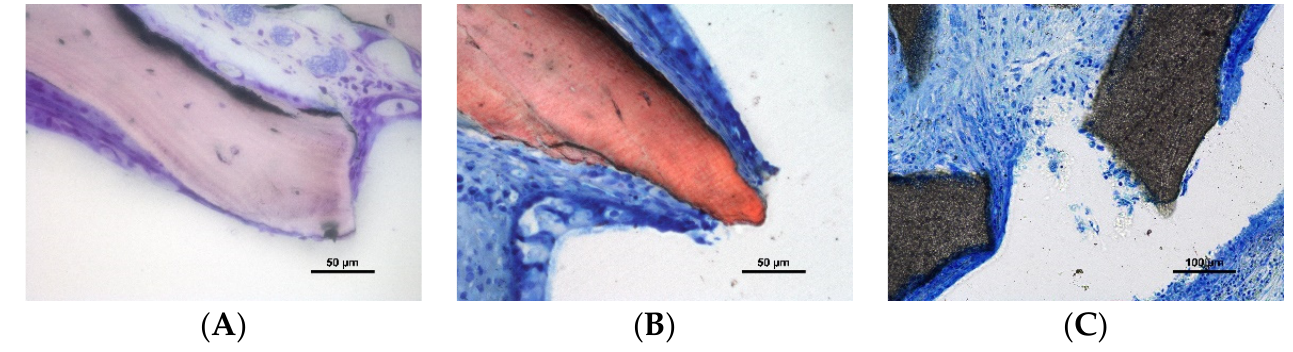
Figure 4. Photomicrographs of ground sections. Perforations of the sinus mucosa. Note the tapered shape of the epithelium in a tentative attempt to protect the subjacent submucosal tissues. ( A , B ) Inflammatory cells were rare; ( C ) inflammatory reaction—note the epithelium trying to isolate the granule on the left side of the image. ( A ) Toluidine blue stain; ( B , C ) Stevenel’s blue and alizarin red stain.